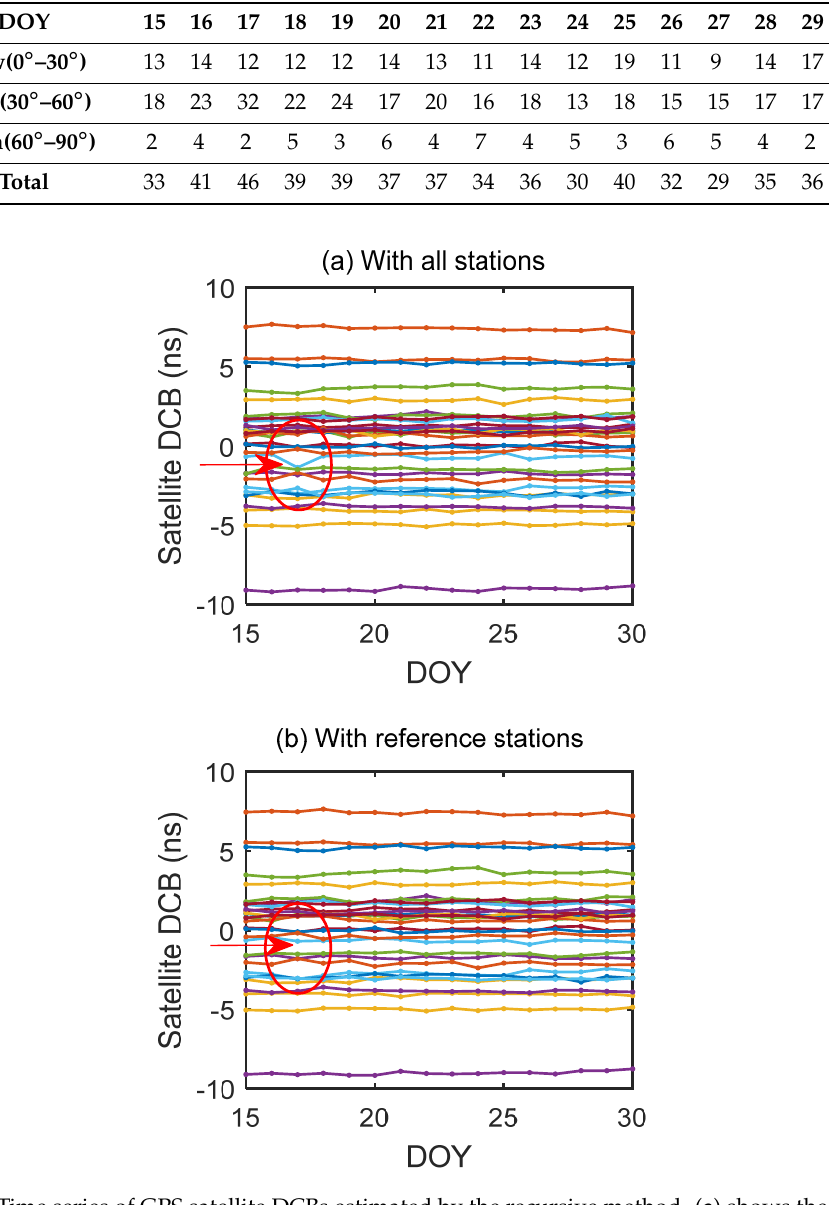
Figure 6. Time series of GPS satellite DCBs estimated by the recursive method. ( a ) shows the results with all station data and ( b ) shows the results with reference station data. The horizontal axis represents the day of year in 2011.